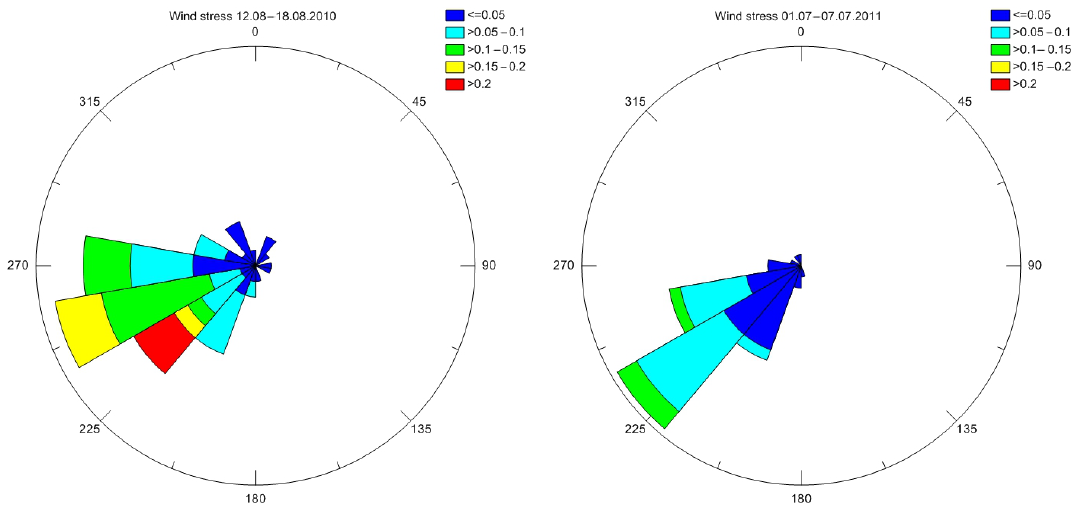
Figure 8. Polar histogram of wind stress vectors (Nm − 2 ) based on the wind data from a weekly period before the peak of upwelling events off the Estonian coast on 17–23 August 2010 (left panel) and 5–11 July 2011 (right